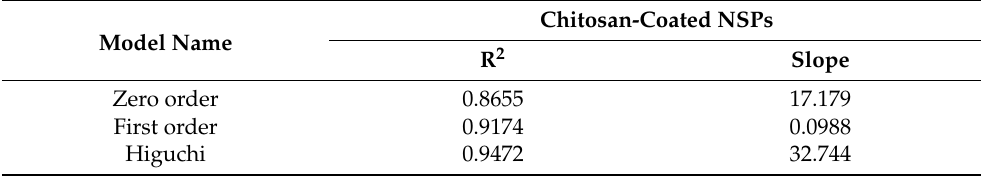
Figure 7. In-vitro release profile of chitosan-coated NSPs and pure BGT and Best fitted Higuchi release kinetic model.